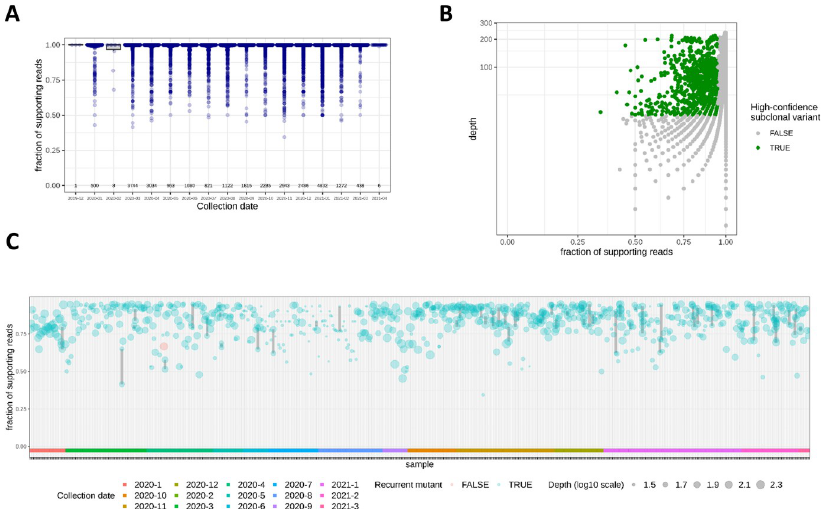
Fig 3. Variant frequencies of spike protein mutants indicate presence of multiple SARS-CoV-2 mutants in some samples. (A) The boxplot shows the distributions of the fraction of supporting reads of the mutations found in the NGS data. The numbers of underlying samples are indicated above the collection dates. Most of the observed variants have a variant allele frequency of > = 0.95 and can be accounted as clonal. (B) Filtering for high-confidence subclonal variants (green) with sequencing depth > = 30 reads and fractions of supporting reads between 0.1 and 0.95. (C) Sample-wise depiction of high-confidence subclonal events. Some of the observed subclonal variants were recurrent (blue) and only few were individual (red). The samples were ordered by collection date (see also color bar at the bottom of the plot) and point sizes indicate sequencing depth (log10 scale). Subclonal variants of the same sample are linked with grey lines. The fraction of supporting reads of variants found in the same sample differed notably in some cases.